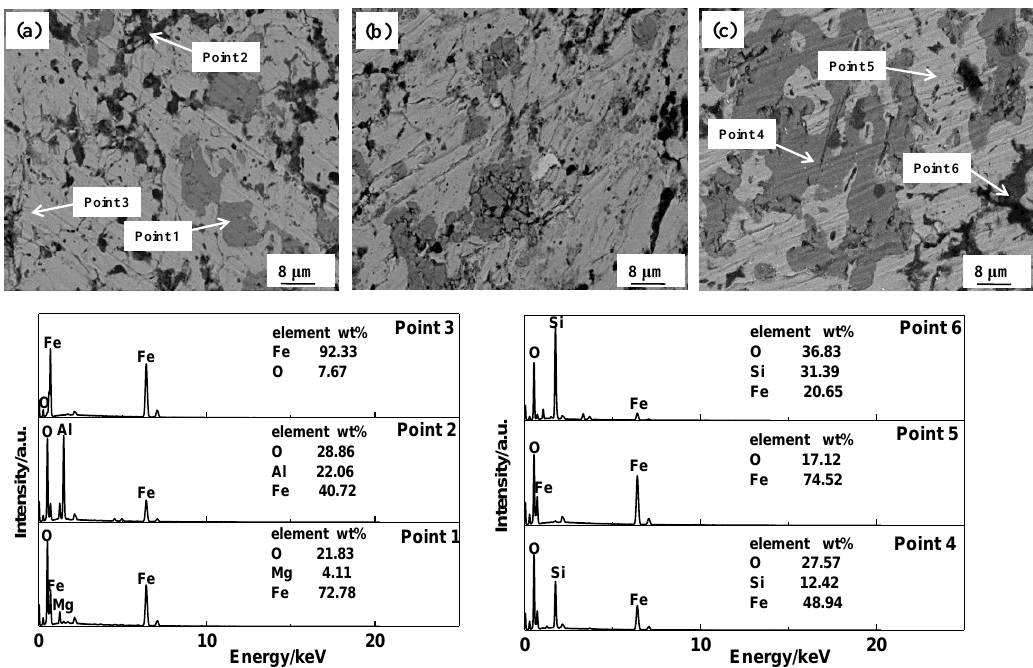
Figure 9. SEM images and EDS analyses of the reduced pellets with different SiO 2 content ( a ) 2.19, ( b ) 4.63, and ( c ) 8.13 wt%.